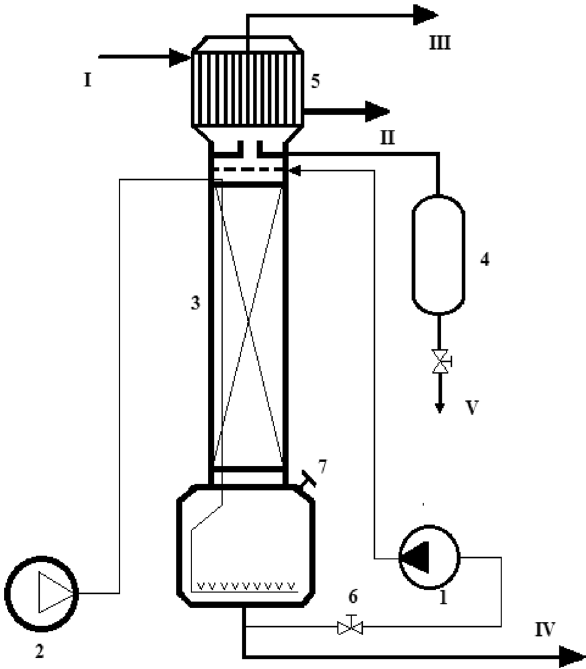
Figure 5. The schematic of the pilot apparatus for the production of oxidized